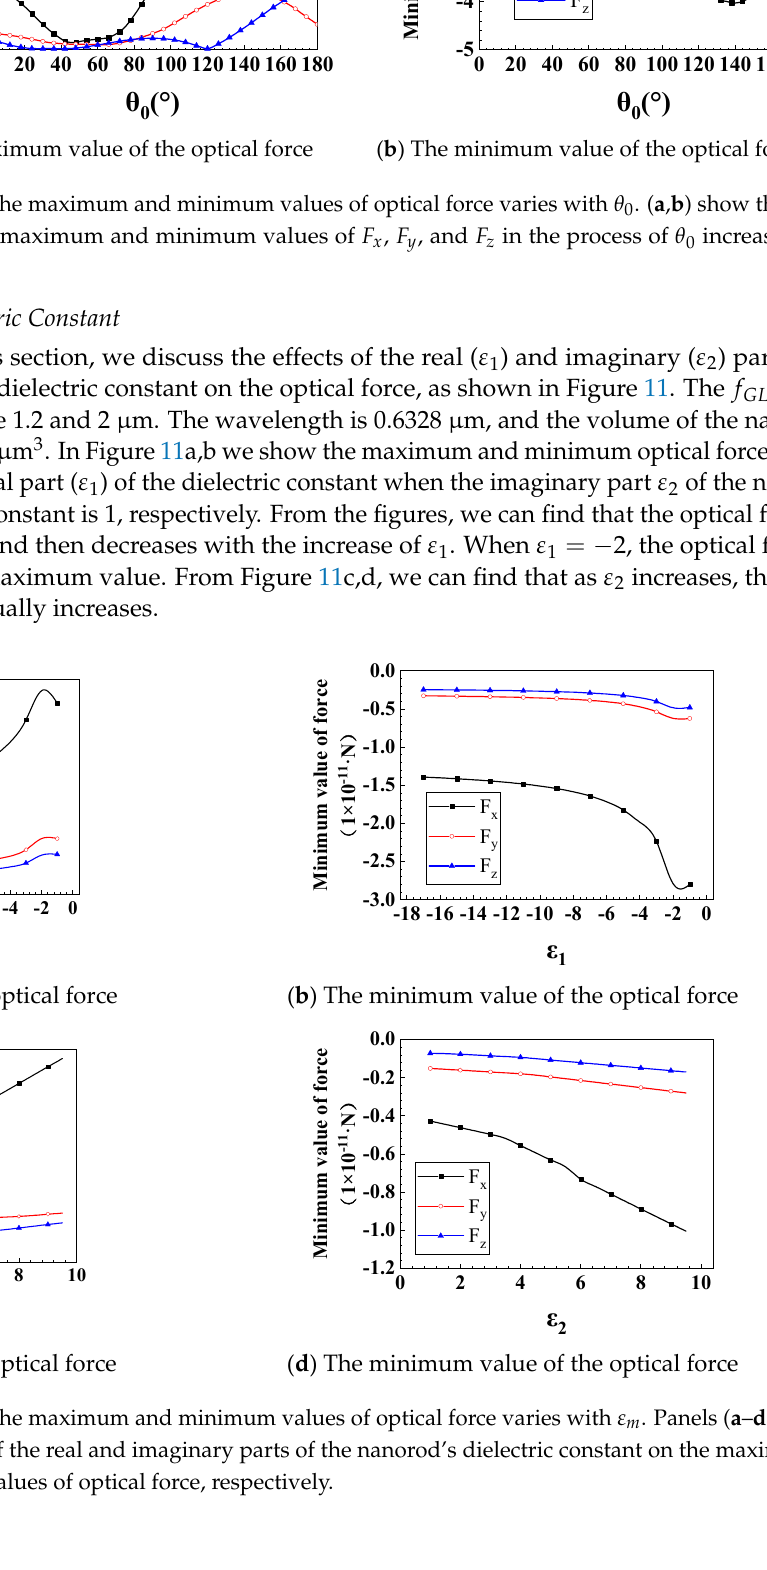
Figure 9. Optical force exerted on a nanorod with different θ 0 . Panels ( a – d ) show the optical forces θ = ° ° ° ° , respectively. F x and F y when 0 0 , 30 , 60 , and 180